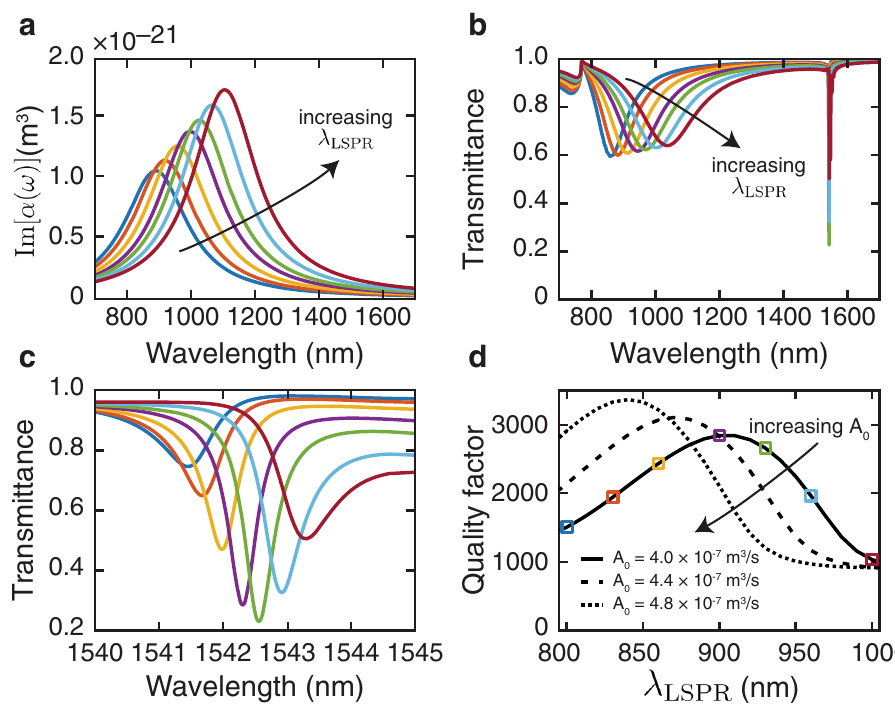
Fig. 2 Coupling to a surface lattice resonance. The colors in a – d are consistent, corresponding to the same type of nanoparticle. a The imaginary part of the individual particle polarizability for various nanostructures with increasing resonance wavelength λ LSPR , holding both the oscillator strength A 0 and the damping term γ fi xed. Here λ LSPR is tuned from 800 to 1000nm. b Simulated broadband transmission spectra for gold nanostructure arrays as a function of tuning λ LSPR . By tuning the LSPR wavelength, the extinction factor of the SLR is observed to change near λ = 1542 nm. While λ LSPR changes dramatically, the SLR wavelength λ SLR does not change much. c Zoomed-in plot of the SLR in b . d The Q -factor of the surface lattice resonance as a function of λ LSPR for various oscillator strengths A 0 . The optimal LSPR wavelength for a high- Q SLR changes as a function of A 0 . The oscillator strength A 0 increases from 3.98 × 10 − 7 to 4.77 × 10 − 7 m 3 /s, roughly corresponding to a 20% increase in the particle volume. The squares indicate the Q values extracted from the curves in c .